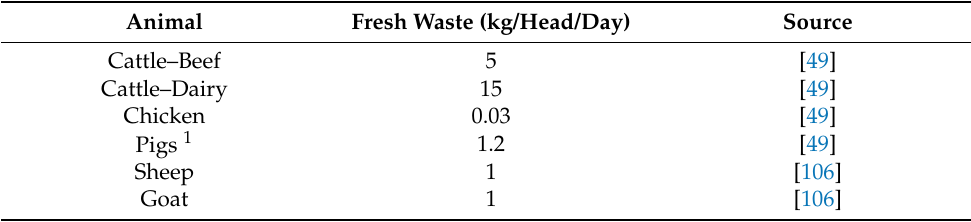
Table A3. Data sources for the fresh waste calculation of animal waste.